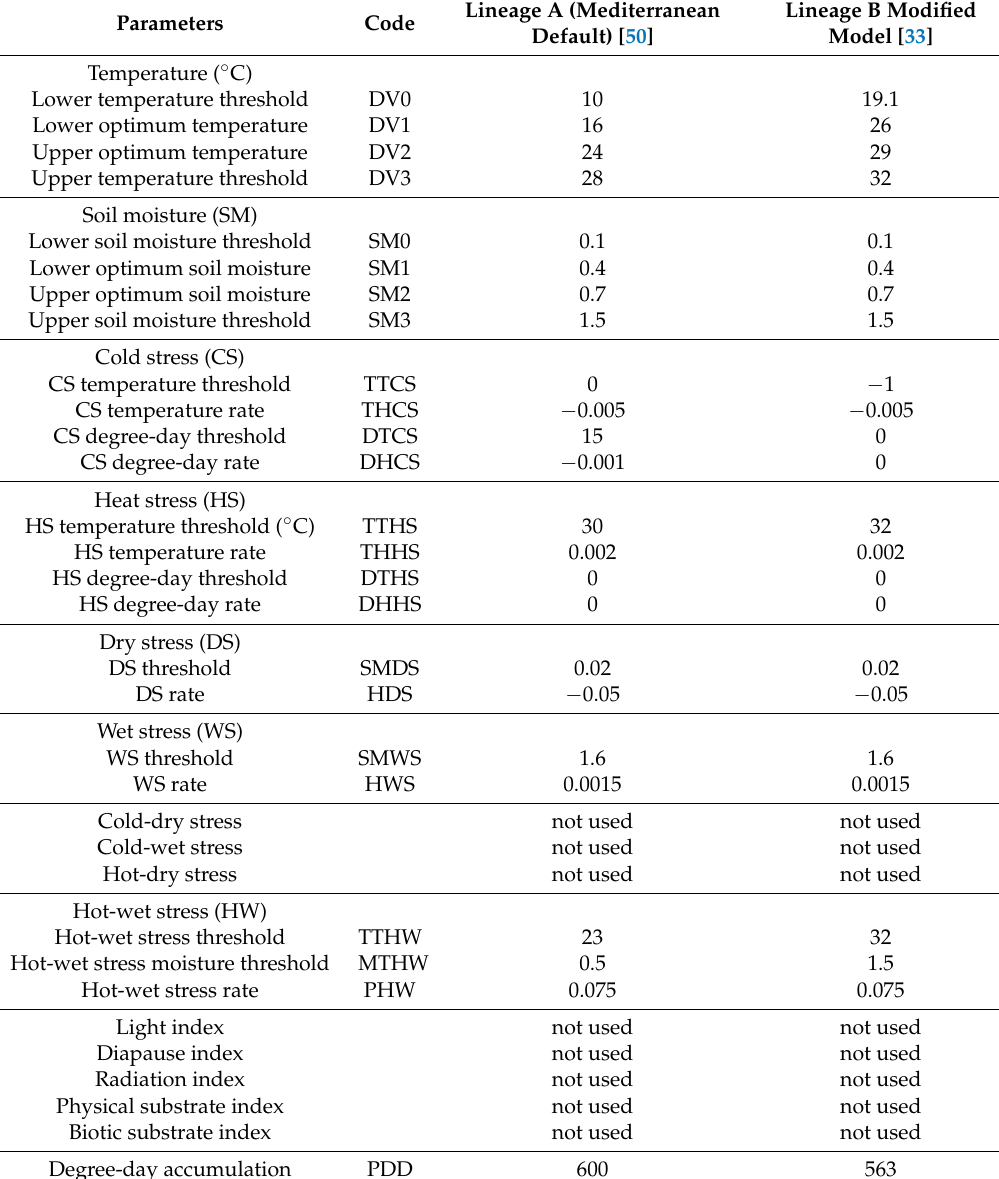
Table 1. CLIMEX parameter values used to model Leptocybe spp.